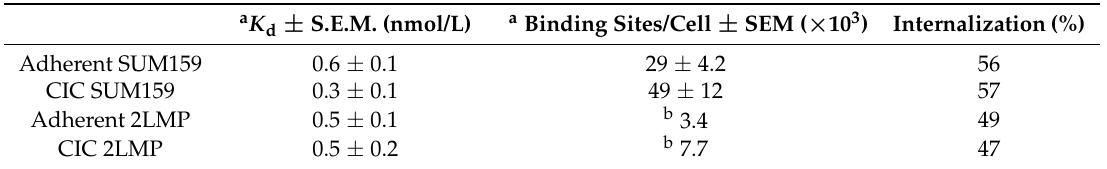
Table 1. In vitro binding analysis of 212 Pb-225.28 to human triple-negative breast cancer (TNBC) cells and cancer-initiating cells (CICs).